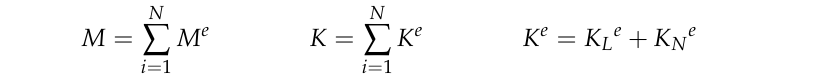
Figure 1. The flow chart of estimation